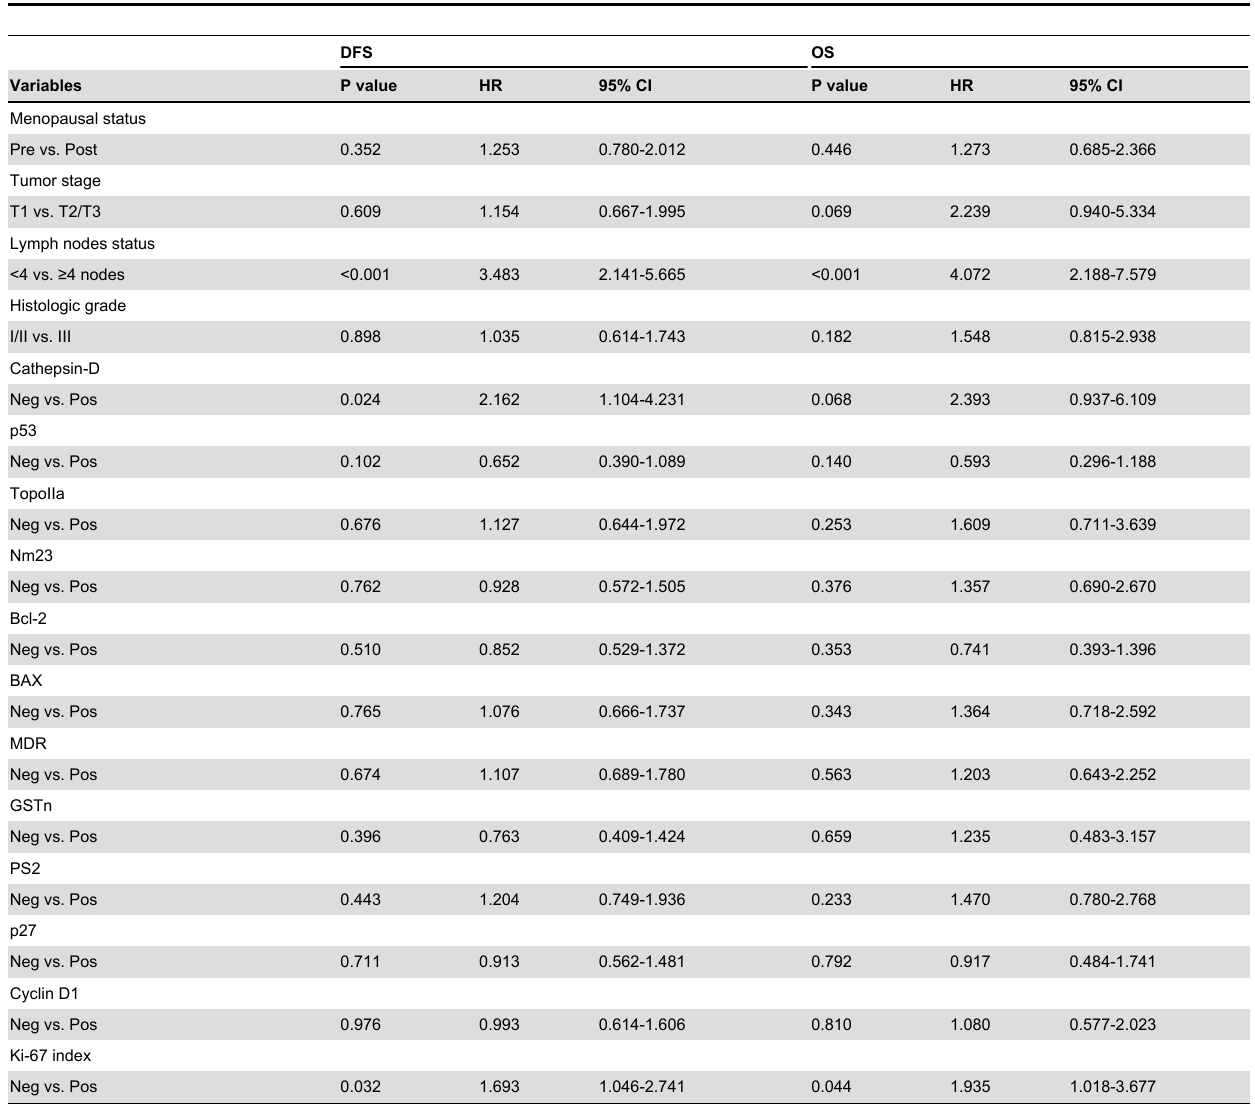
Table 2. The univariate analysis of DFS and OS for patients of the training